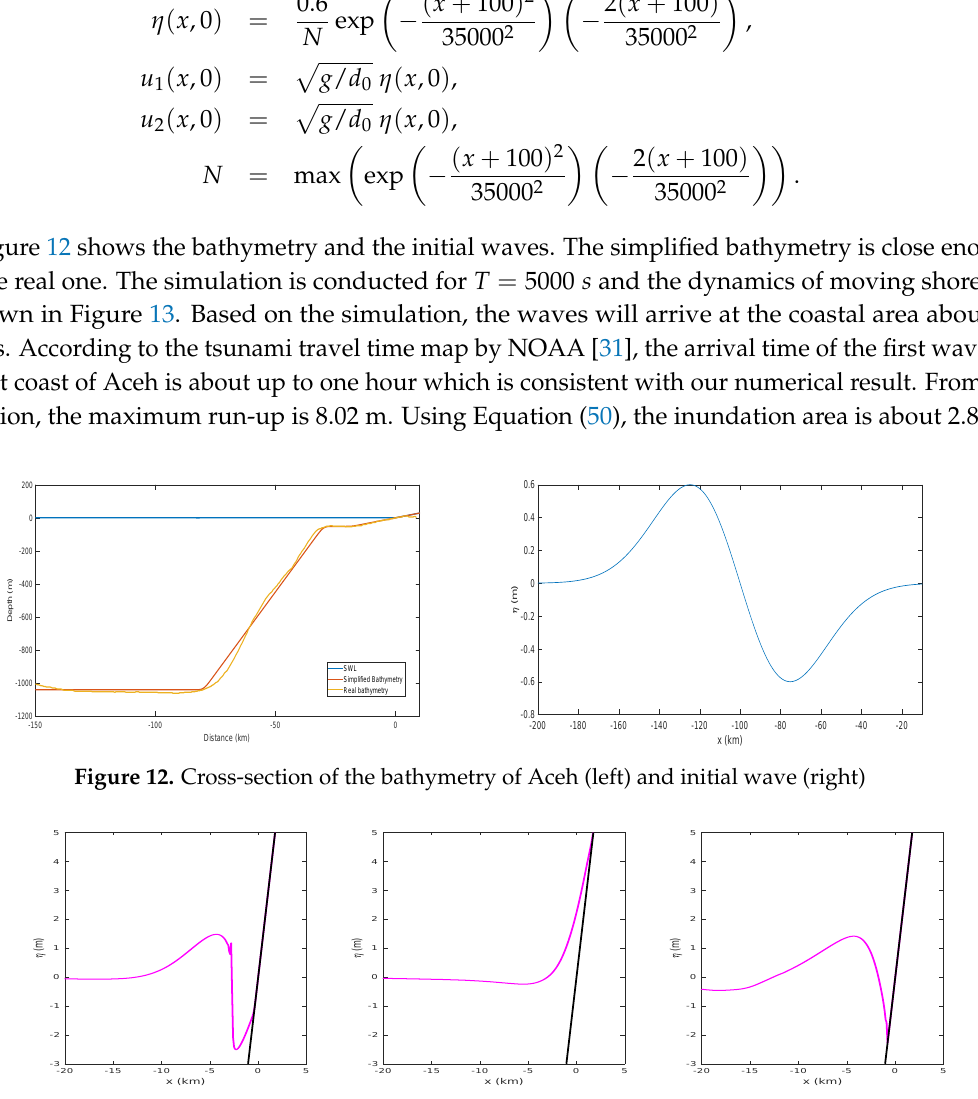
Figure 13. Wave run-up on simplified Aceh beach at t = 2500 s (left), t = 3000 s (middle) and t = 4000 s